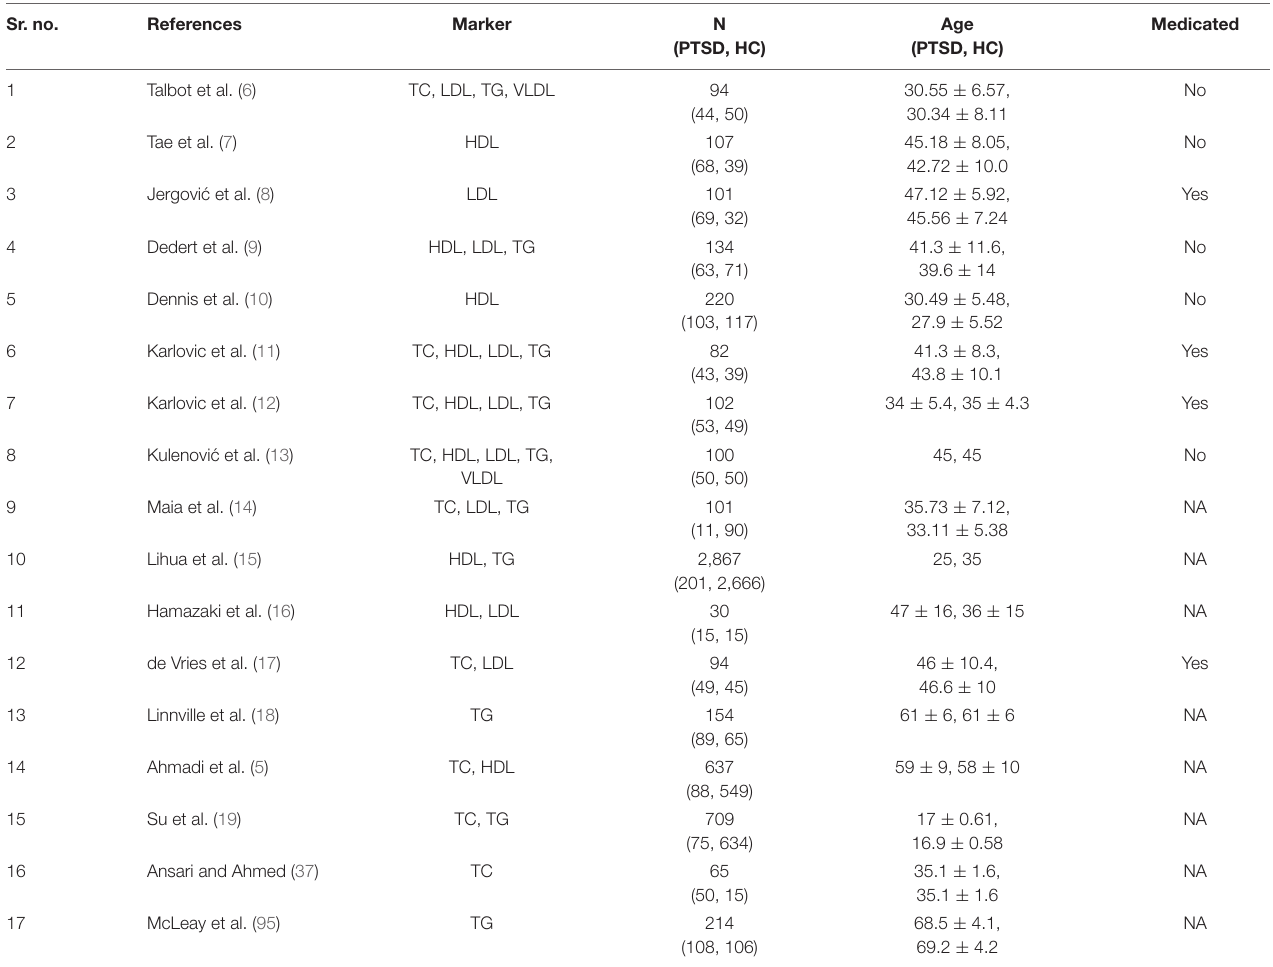
TABLE 1 | Characteristics of studies included in the meta-analysis. Sr.